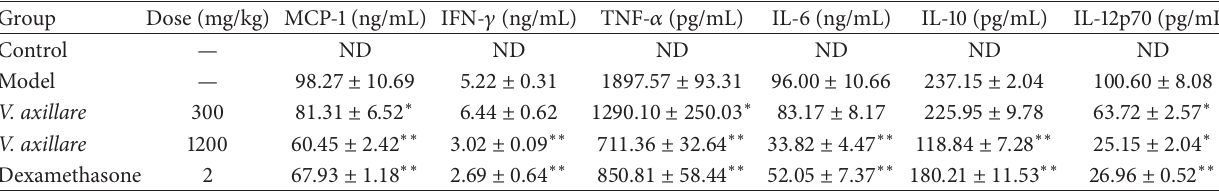
Table 2: Effect of V. axillare on serum inflammatory cytokines in LPS-challenged mice a .